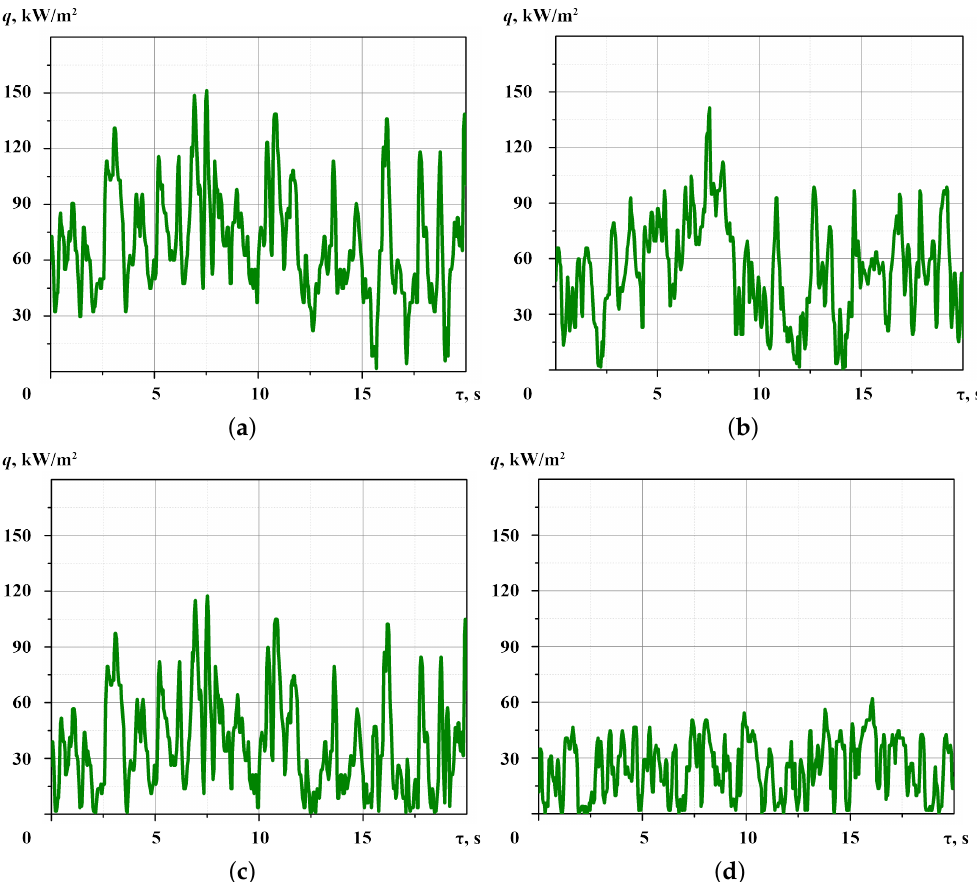
Figure 3. Time-dependent heat flux graph by HGHFS for condensation of saturated steam on the upper generatrix of the pipe at the surface temperature: ( a )—322 K; ( b )—337 K; ( c )—354 K; ( d )—362